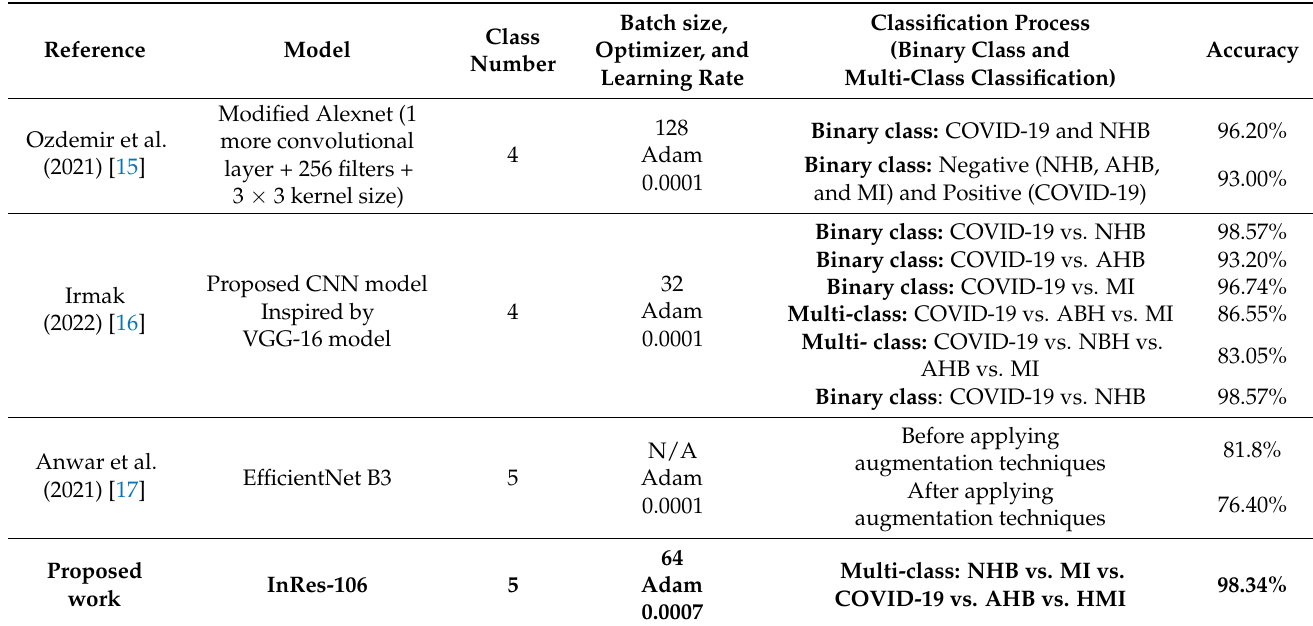
Table 8. Accuracy comparison with existing studies using the “ECG Images dataset of Cardiac and